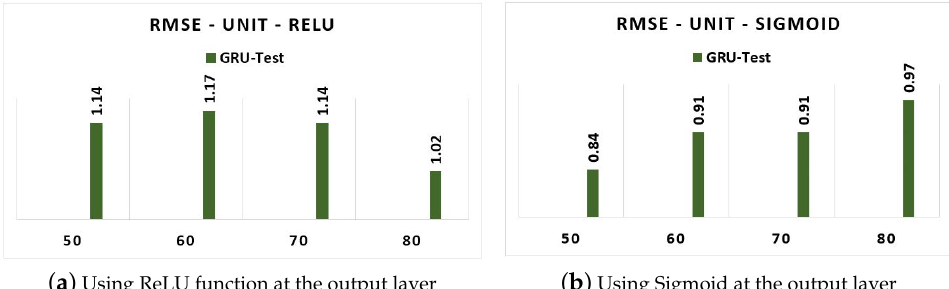
Figure 15. RMSE errors measured, with different numbers of cells in the hidden